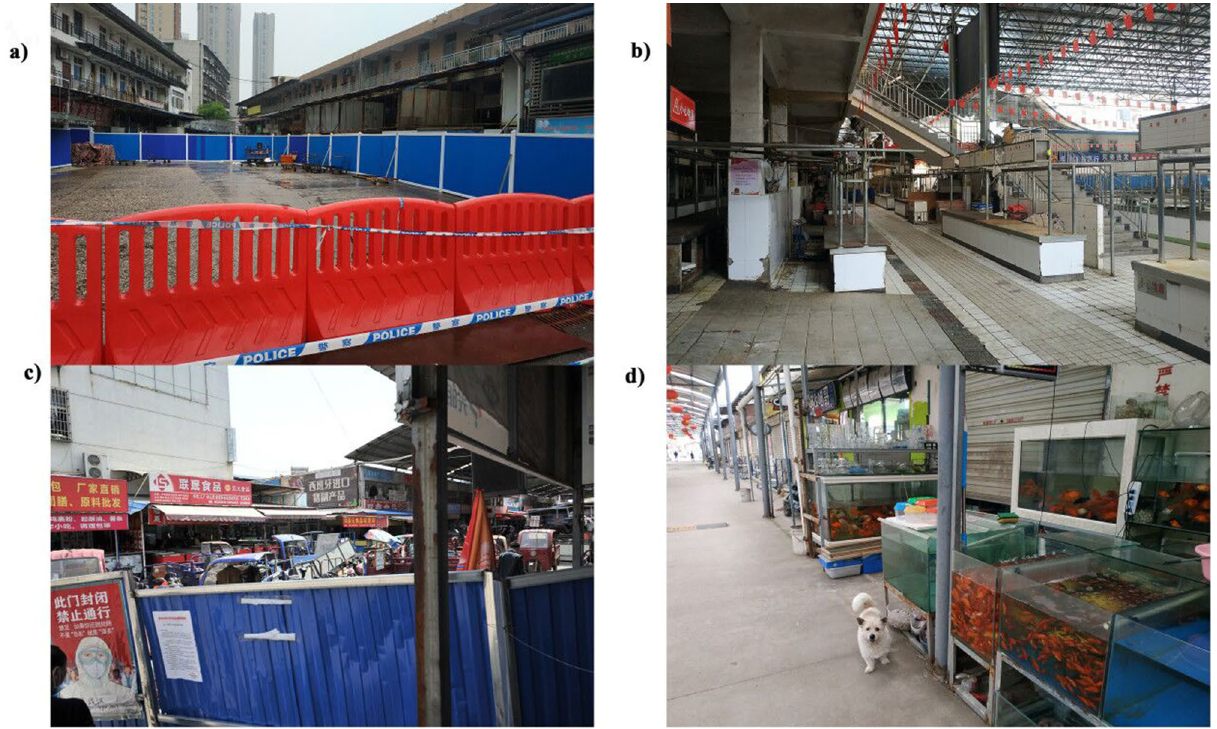
Figure 1. ( a ) Huanan Seafood market, ( b ) Qiyimen live animal market, ( c ) Baishazhou market and ( d ) Dijiao outdoor pet market (note stray dog) photographed on 10th April